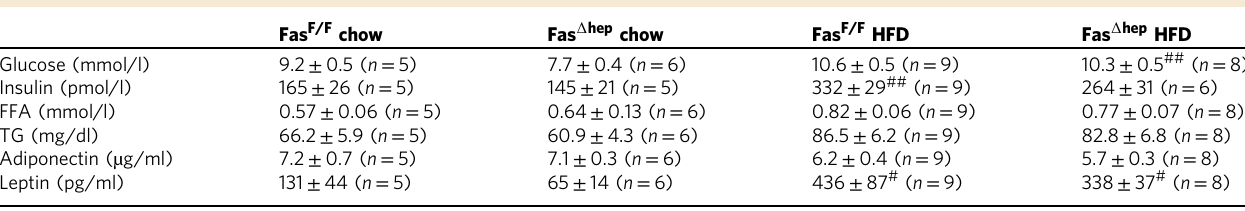
Mice were fasted for 5h before blood sampling. Values are expressed as mean ± s.e.m. # P < 0.05 and ## p < 0.01 indicate signi fi cant differences between diets of the same genotype (ANOVA)